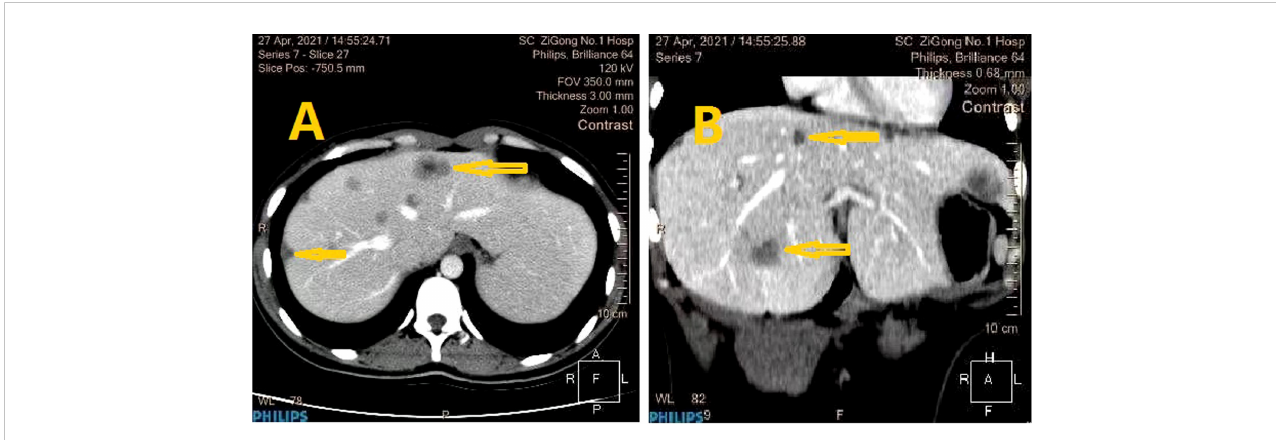
FIGURE 4 CT imaging: The metastatic liver lesion and low-density lesions in the liver was shown by CT (lesion was marked with yellow arrow) [ (A) , (B) re fl ect different anatomical